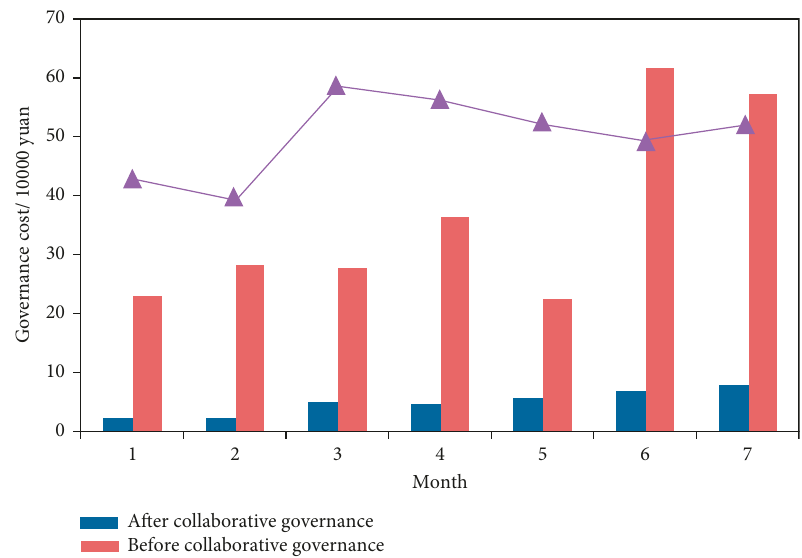
Figure 5: Comparison of water pollution control costs before and after adopting the designed method.